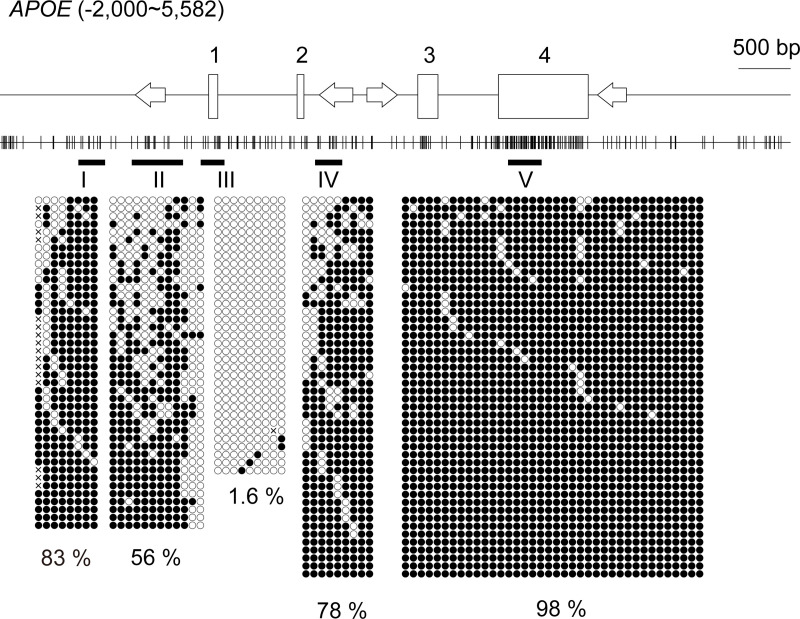
Relative positions of CpG dinucleotides selected for the methylation analysis in APOE.The schematic shows the distribution of CpG dinucleotides along APOE. The position of the transcription start site is defined as +1; hence, “-2,000” in the parenthesis indicates that the diagram includes 2 kb upstream of APOE, whereas “5,582” in the parenthesis is the position 2 kb downstream from the end of the last exon. Vertical lines indicate the positions of CpG dinucleotides. Open rectangles depict exons and exon numbers are shown above the rectangles. Four arrows indicate Alu elements in the locus and their orientations relative to the coding strand of APOE [32]. The fundamentals of these diagrams were automatically drawn by the web-based tool CyGnusPlotter. It collects the genomic structure of the most representative isoform of a requested gene from the Ensembl database with upstream and downstream regions of the designated lengths. Black horizontal bars with Greek letters (I-V) indicate the regions for bisulfite sequencing. Filled and open circles represent methylated and unmethylated cytosines, respectively. Each column represents a unique CpG site in the examined amplicon and each line is an individual DNA clone. Crosses indicate positions at which CpG is absent due to DNA polymorphisms. The percentages of the mean methylation levels derived from four subjects are shown at the bottom. There was a conventional CpG island (region III) that covers exon 1. Moderate (~50%) DNA methylation was observed at a limited region (II) juxtaposed to the CpG island, a region called the “CpG island shore”.